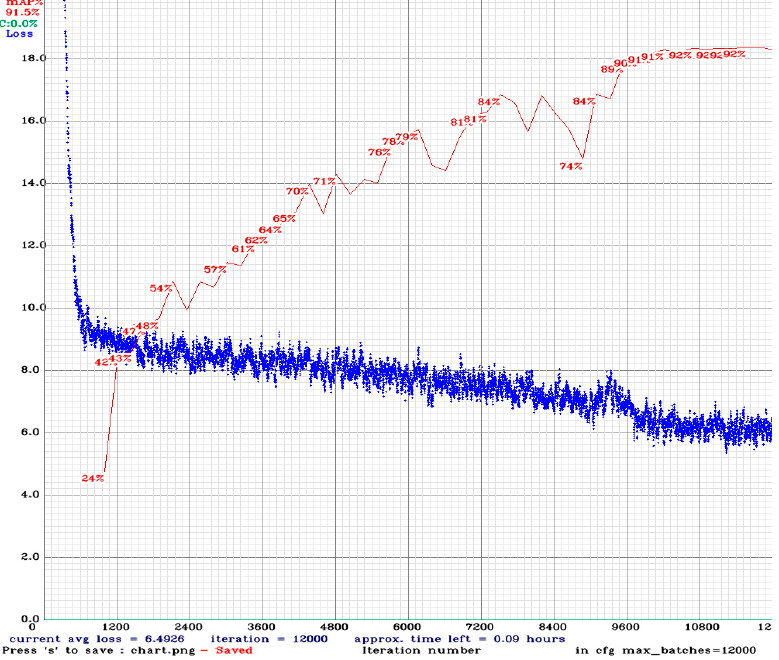
Figure 13. Model training results.